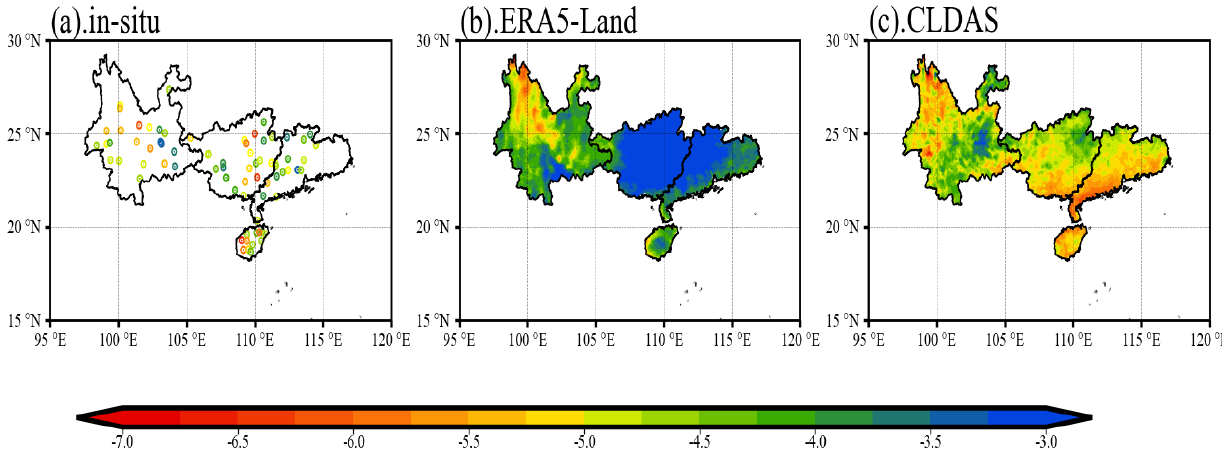
Figure 2. Spatial distribution of the average SWDI based on the in situ ( a ), ERA5-Land ( b ), and CLDAS ( c ) soil moisture data from 2013 to 2017.